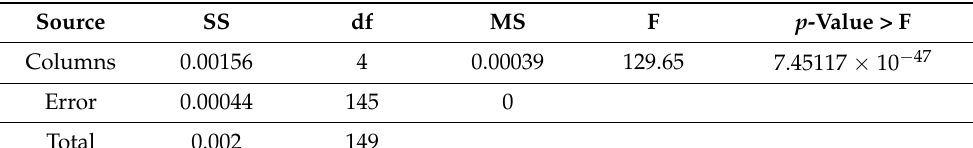
Table 5. ANOVA results for control.